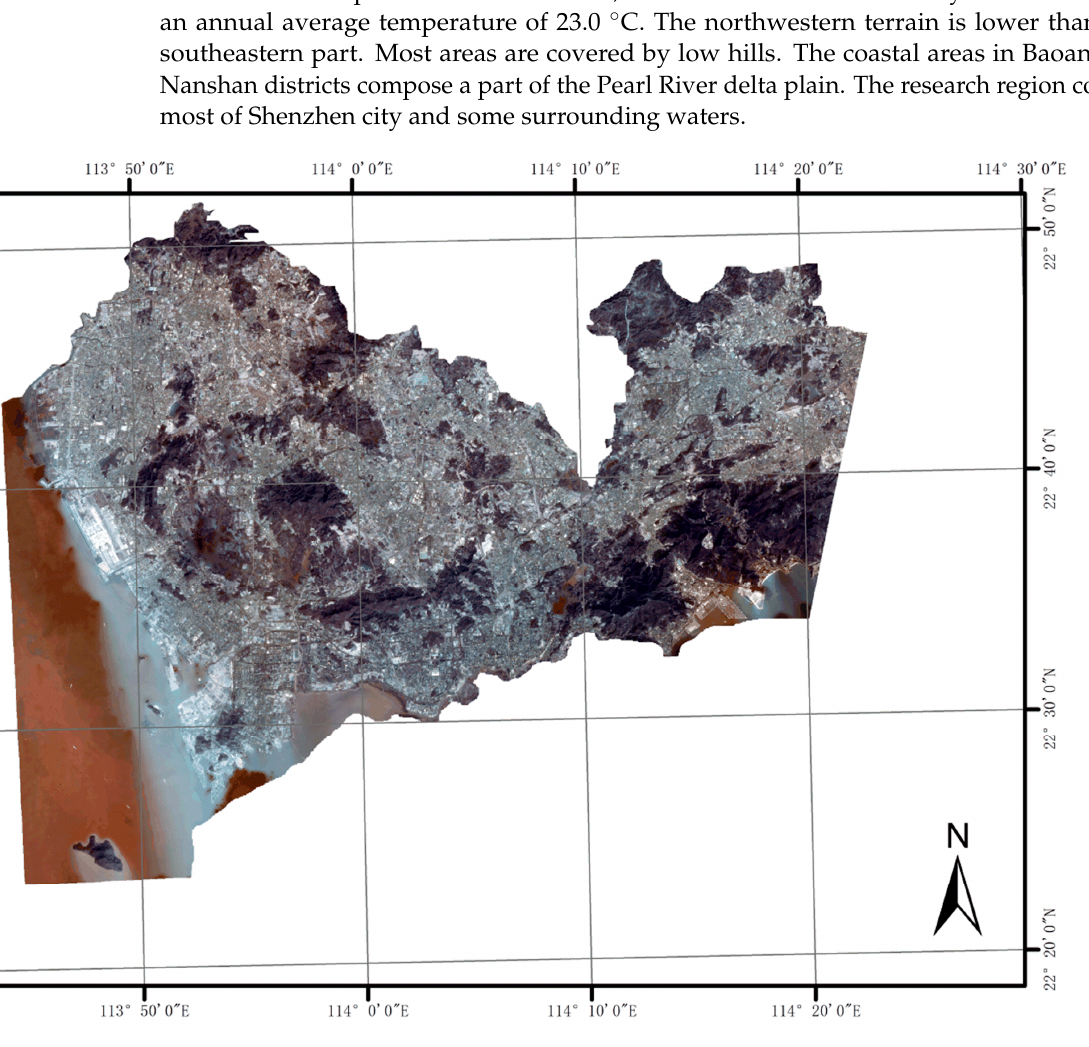
Figure 1. The TM false color image in the research